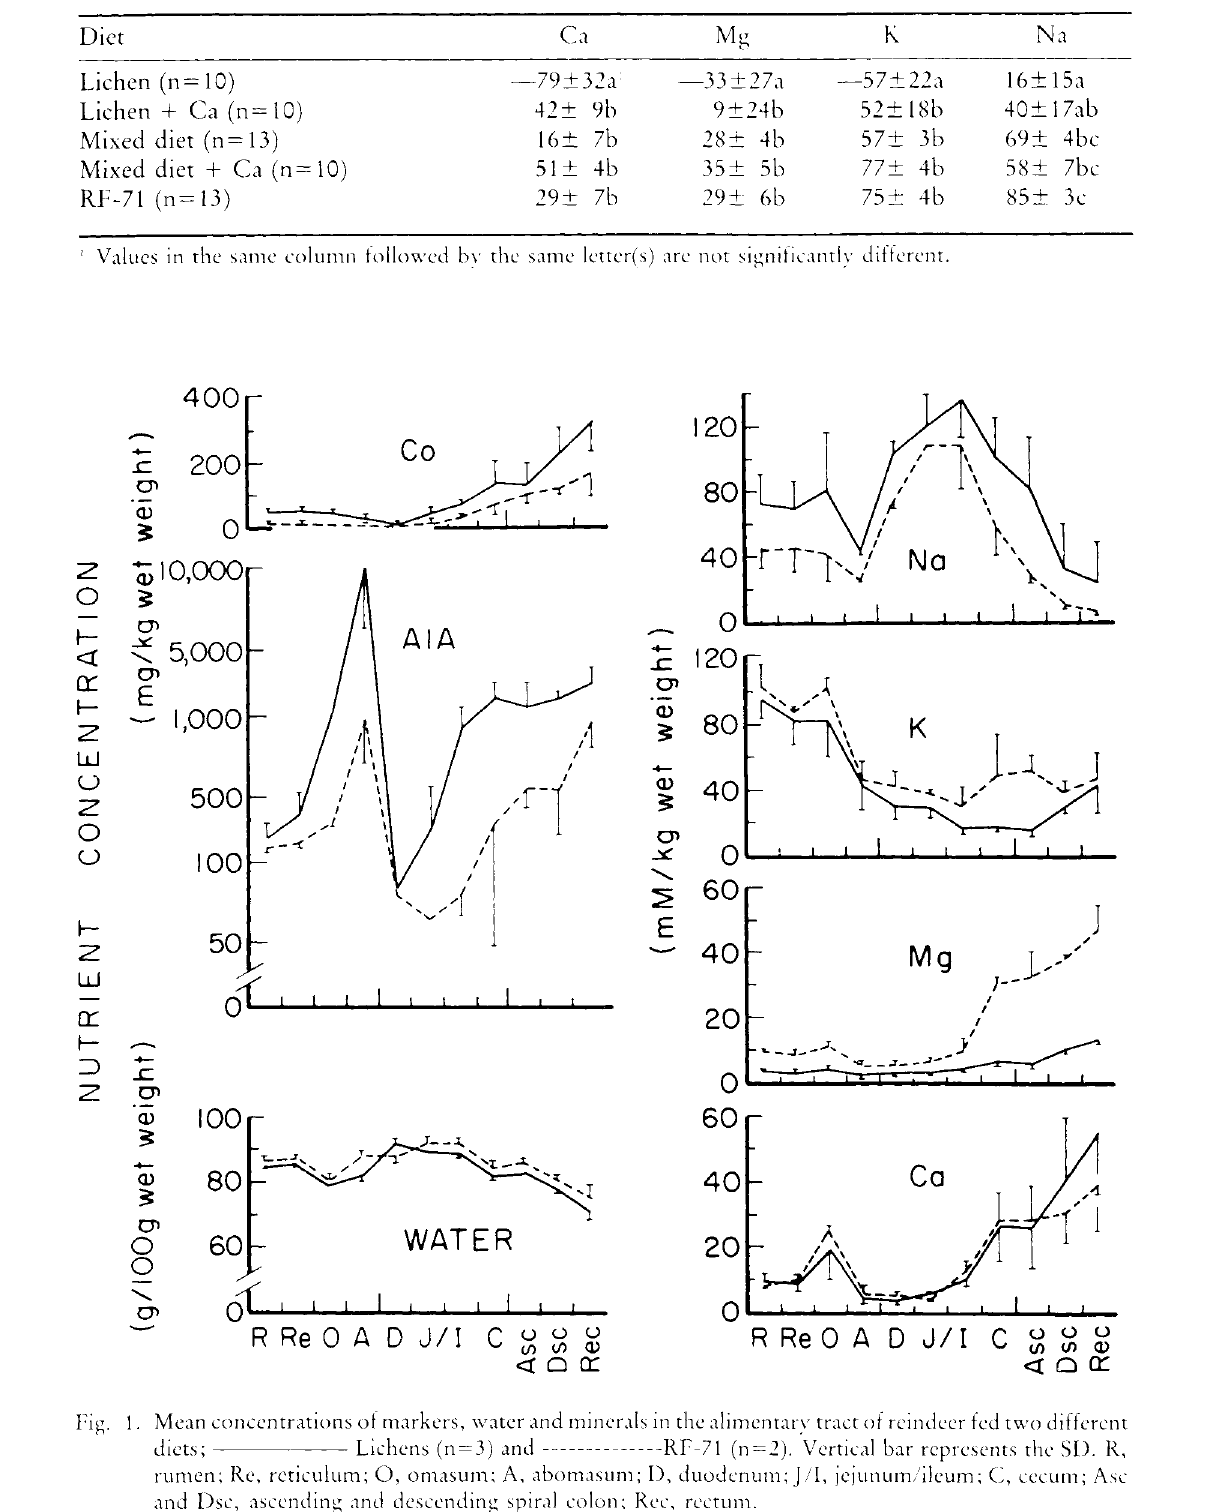
Table 4. Mineral digestibility in reindeer fed different diets (x%±S.F.).